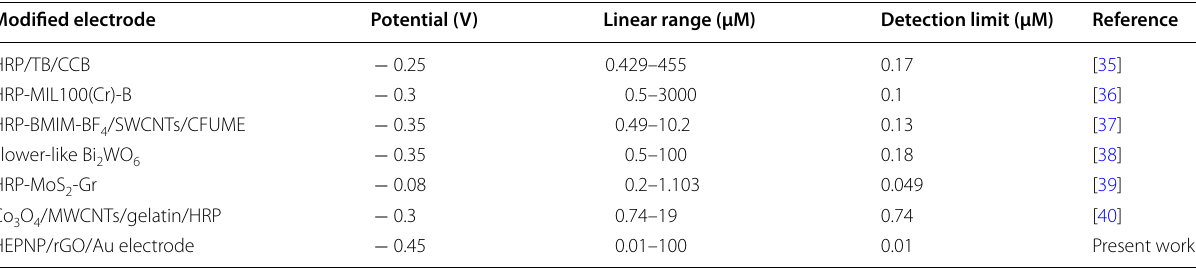
TB toluidine blue, CCB ceramic composite biosensor, MIL100(Cr)-B mil100(cr)-b boronic acid functionalized metal–organic frameworks, BMIM 1-butyl-3- methylimidazolium tetrafluoroborate, SWCNTs Single-walled carbon nanotubes, CFUME Carbon fiber ultramicroelectrodes, MoS 2 molybdenum disulfide gr graphene, Co 3 O 4 cobalt oxide, MWCNTs multiwall carbon nanotubes, HEPNP horseradish peroxidase encapsulated protein nanoparticles, rGO reduced graphene oxide Au: gold electrode